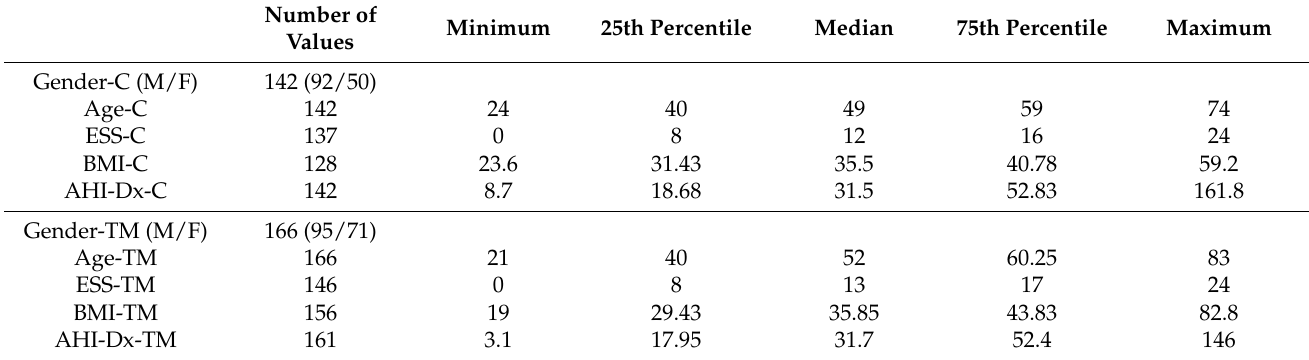
Table 2. Patient demographics and baseline characteristics; The control and intervention groups